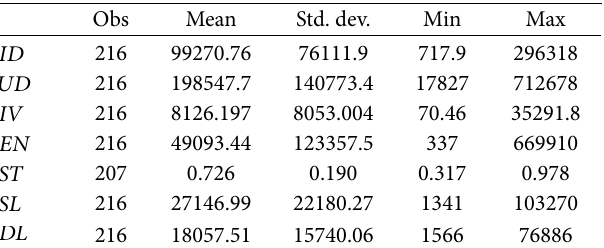
Table 3: Fitting and comparison of predictive variables.